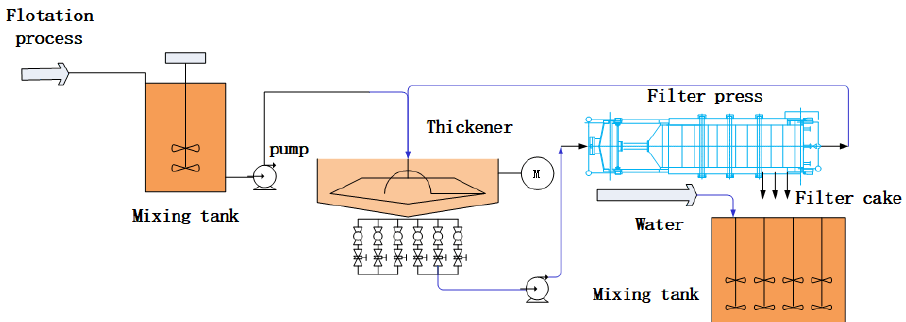
Figure 5. Process flow chart from flotation to thickening.